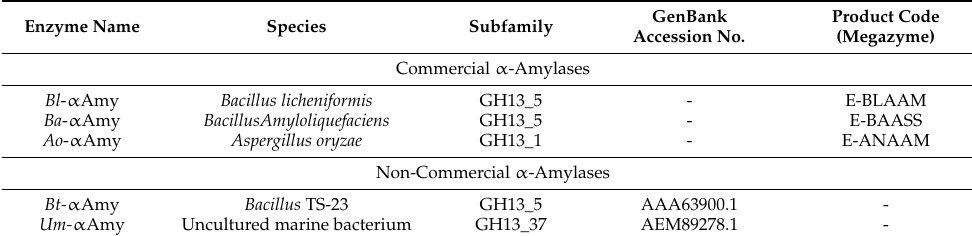
Table 1. List of the five α -amylases employed in the